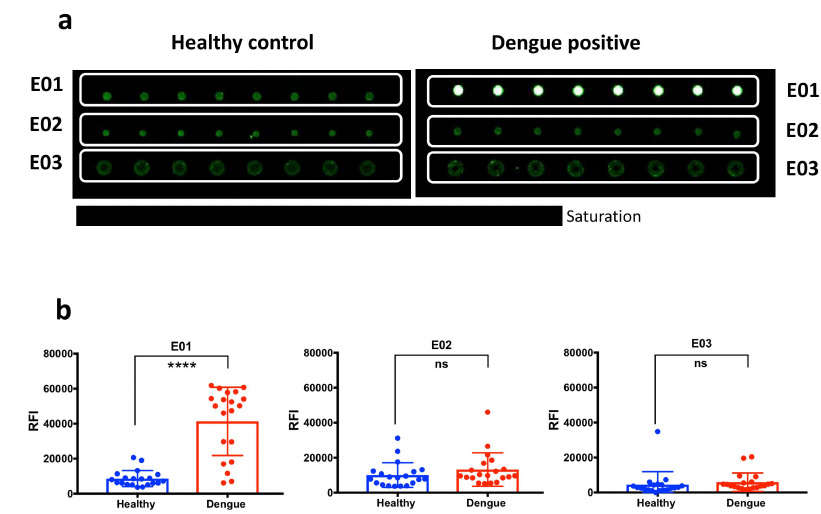
Figure 3. ( a ) Spotting scheme and fluorescence images for the analysis of a representative dengue positive serum and a healthy control. Image acquired at 50% laser power and 10% Photo-Multiplier (PMT) gain. ( b ) Scatter plots reporting individual and mean immunoreactivity with standard deviation (SD) of dengue positive and healthy control individuals and results of the unpaired t Test dengue infection diagnosis. ns = not significant. Significant: **** p < 0.0001.